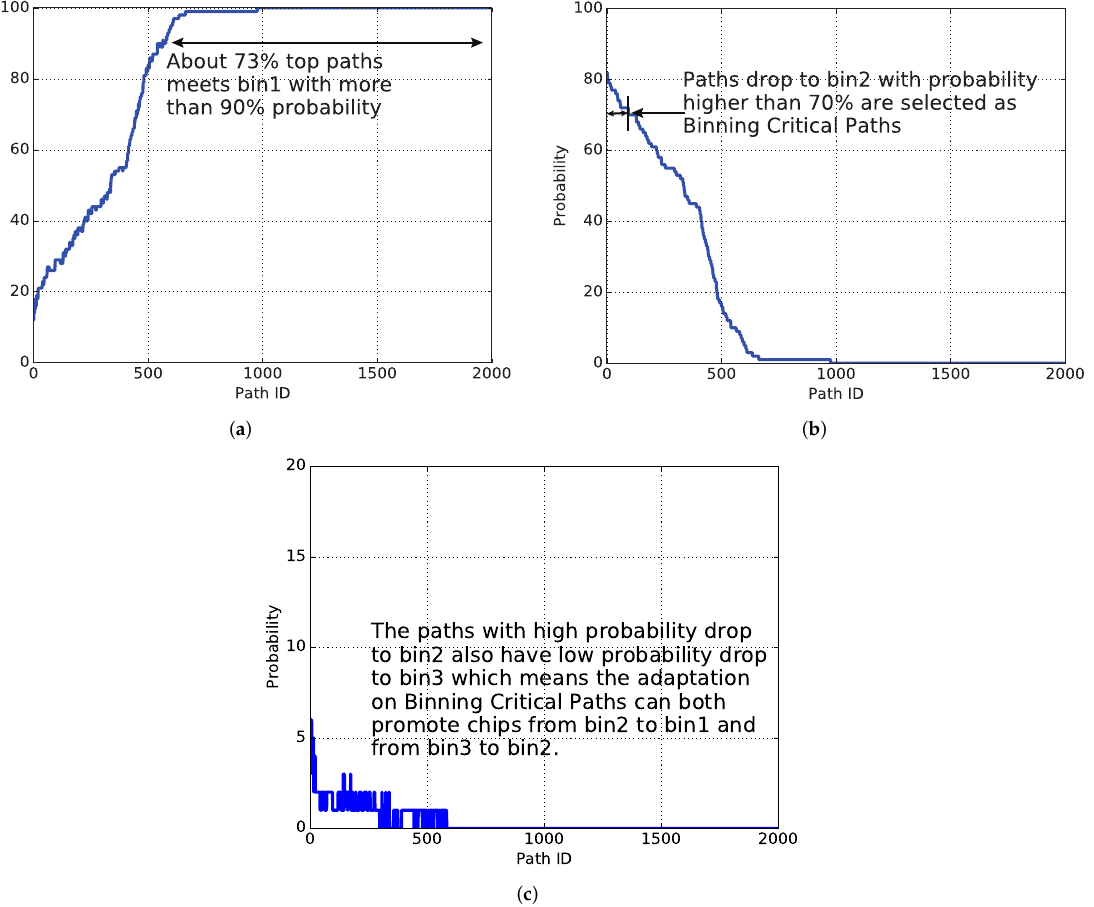
Figure 10. For the first silicon, the Binning Critical Paths are selected based on statistical timing analysis. The paths with high probability ( δ = 70% in this implementation) falling into the lower bins are selected as Binning Critical Paths . ( a ) The probability of ITC’99 b19 top 20% paths locate in bin1; ( b ) The probability of ITC’99 b19 top 20% paths locate in bin2; ( c ) The probability of ITC’99 b19 top 20% paths locate in